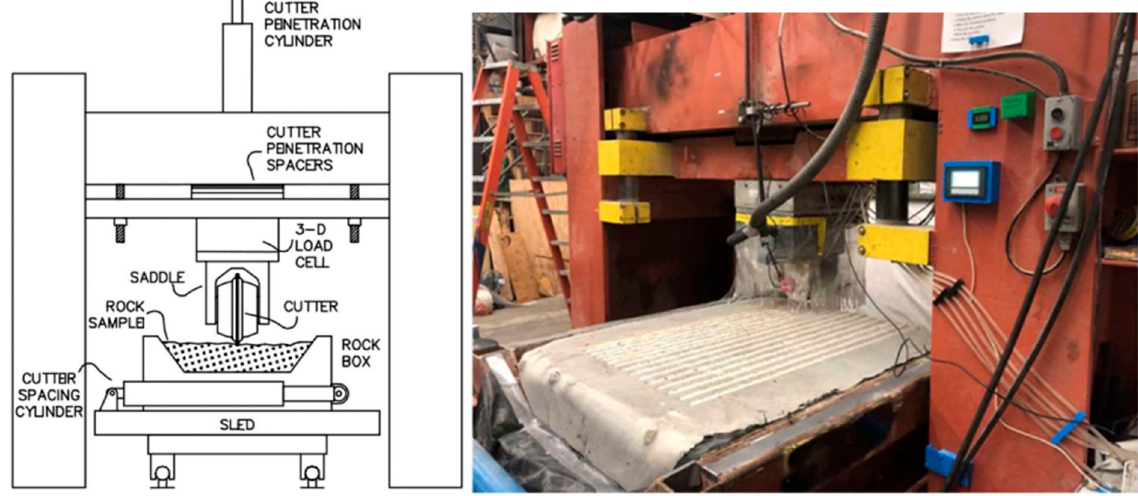
Figure 8. LCM stand for testing picks and discs